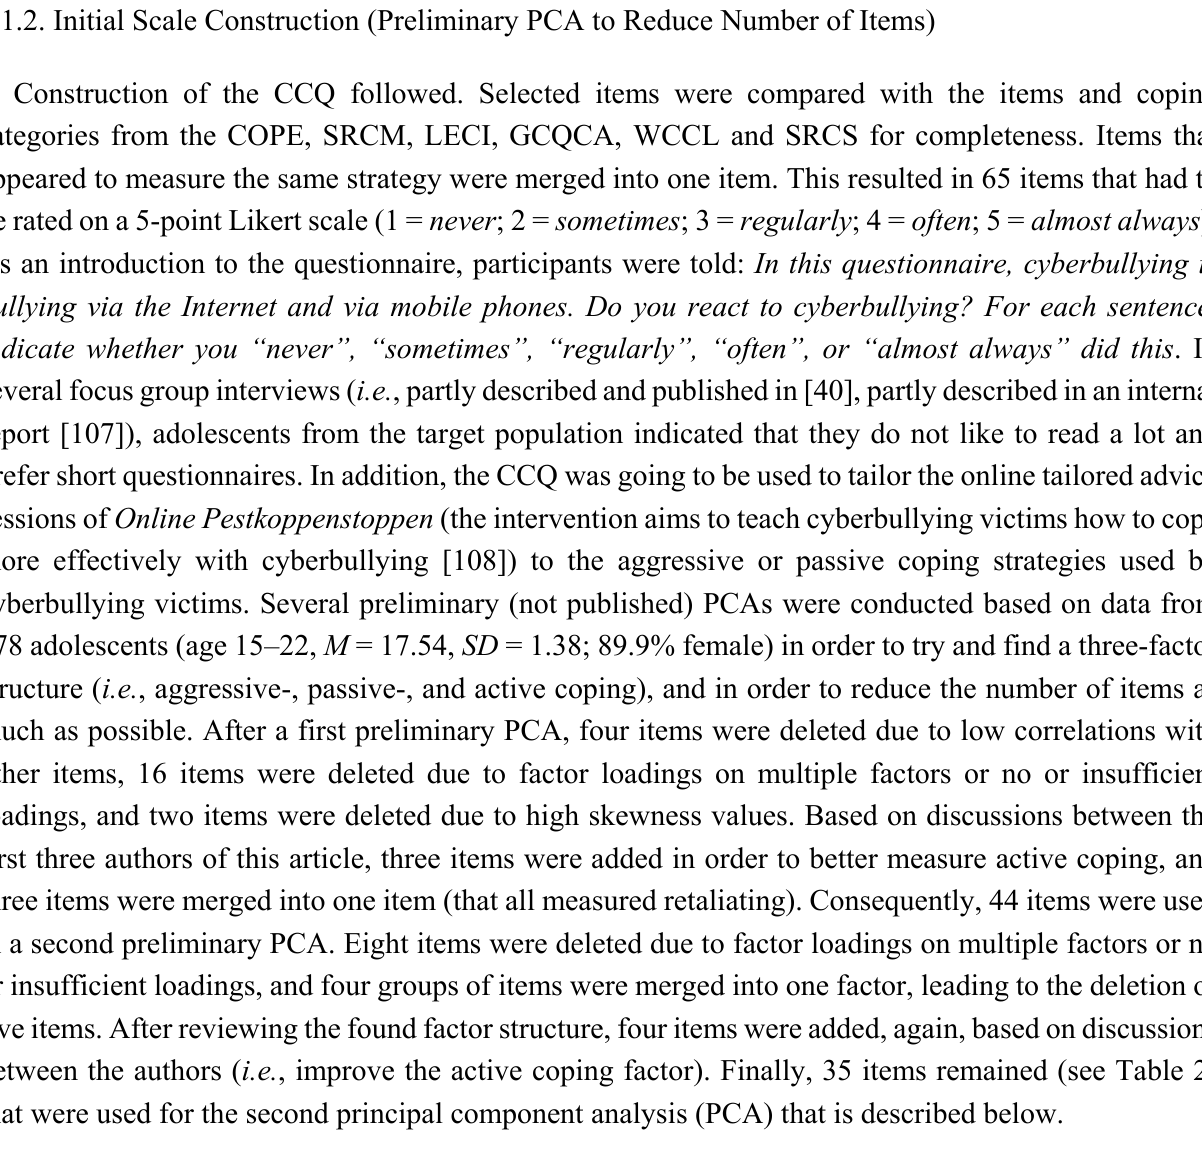
Table 2. Overview of questions of Cyberbullying Coping Questionnaire